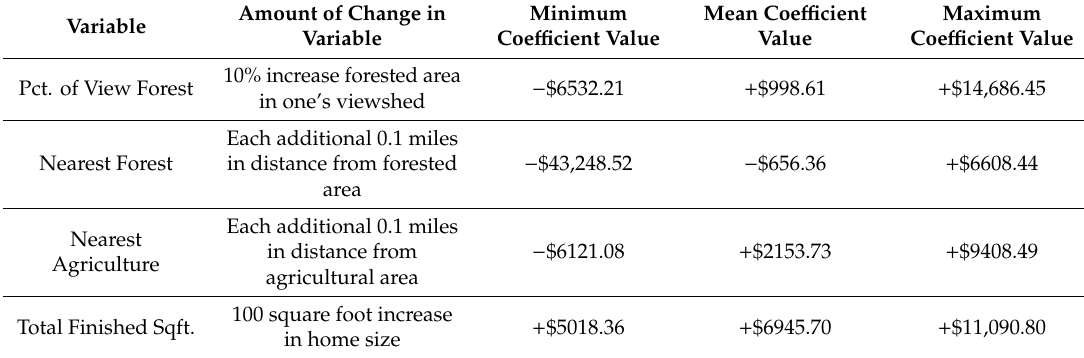
Table 5. GWR willingness to pay estimates of the environmental “focus” variables compared to total finished square footage. Measured via impact on the mean sale price ($182,998.40) at minimum, mean, and maximum GWR coe ffi cient